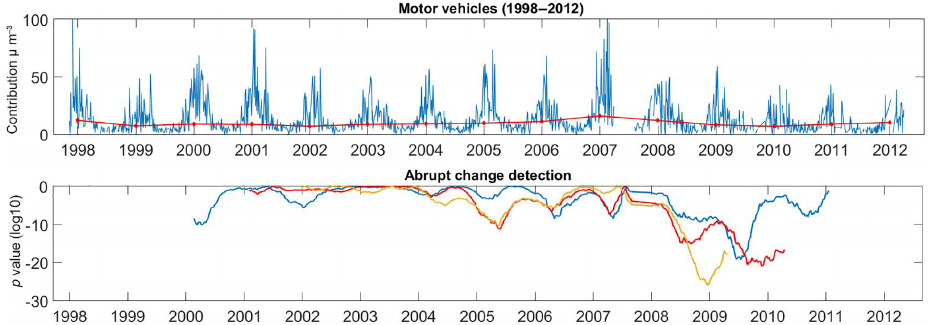
Figure 4. Top panel: time series of motor vehicles’ contribution to PM 2 . 5 and the annual median in red. Bottom panel: p value from a Mann–Whitney hypothesis test comparing the medians of both halves of a sliding window, repeated for three different window lengths (320, 480 and 640 days for blue, red and yellow,